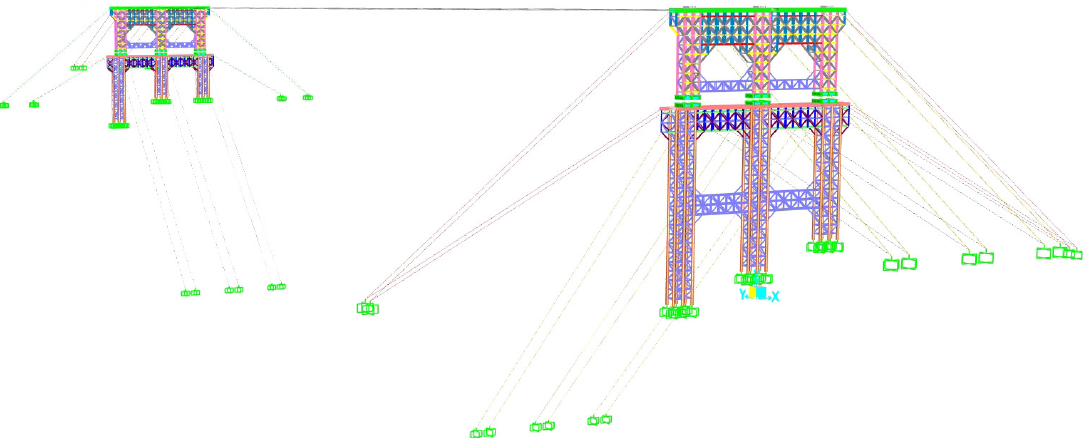
Figure 7. Overall numerical calculation model.